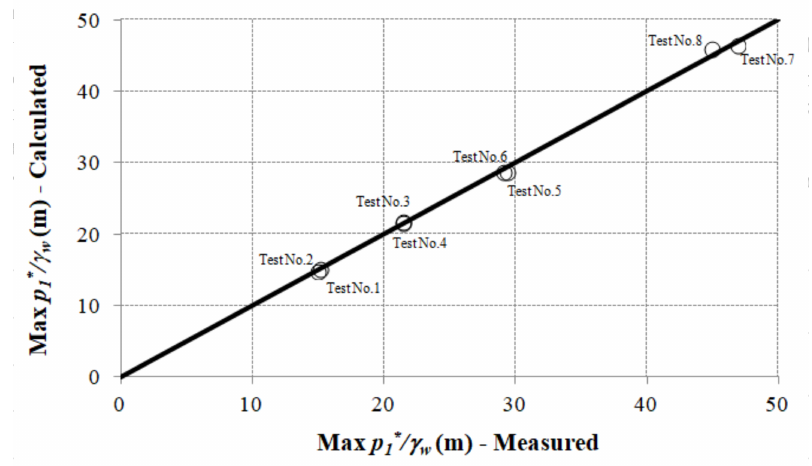
Figure 5. Comparison between calculated and measured maximum air pocket pressure.